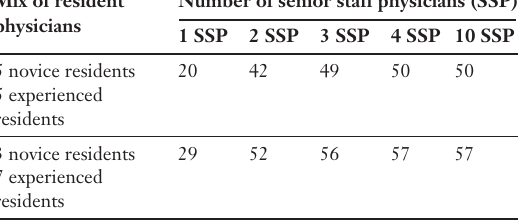
Performance of the outpatient setting expressed as number of seen patients per 5-hour